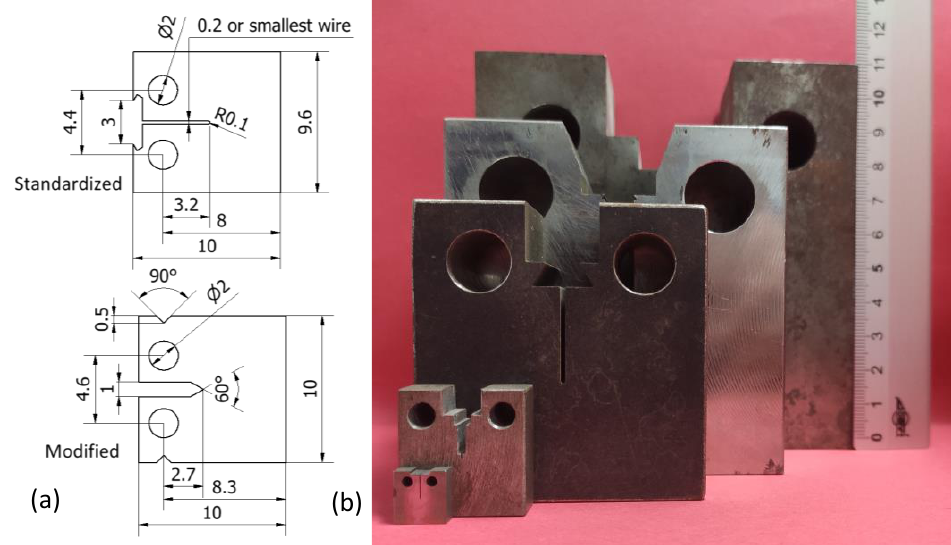
Figure 2. ( a ) Standardized mini-CT vs. modified mini-CT (dimensions in mm); ( b ) image showing the scales of different CT specimens and a standardized mini-CT.